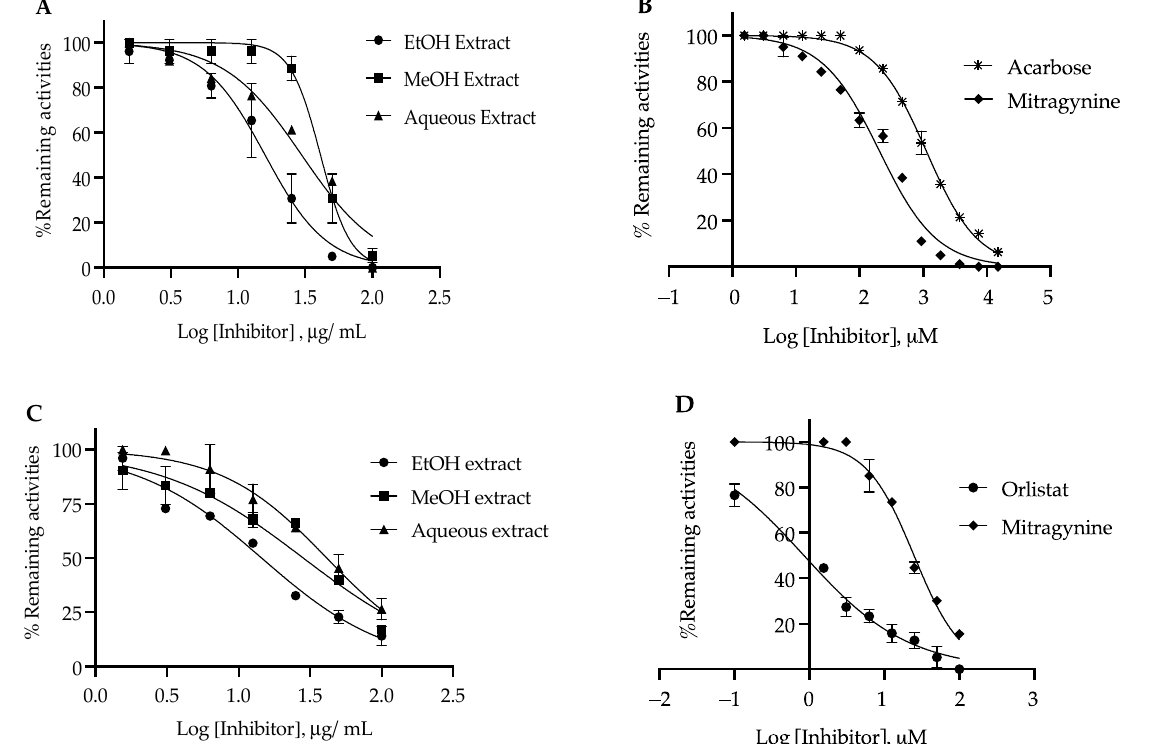
Figure 3. Inhibitory effect of the kratom extracts and mitragynine against α -glucosidase ( A , B ) and pancreatic lipase ( C , D ). Inhibition curves of acarbose ( B ) and orlistat ( D ) were used as positive controls. The inhibition kinetics of acarbose and kratom extracts against α -glucosidase were analyzed using the Lineweaver–Burk plots of the inverted values of velocity (1/V) versus the inverted values of substrate concentration (1/[S]), which are presented in Figure 4A–D. The drug acarbose showed the intersection of the lines on the ordinate, indicative of mixed- type inhibition. The results showed that k m 0.3 mM and V max (28 µ mol/min/mg) were consistent with a previous report [39]. The K i of each mode was evaluated (Figure 4A,B). The intersection on the abscissa yielded a K i value of acarbose (0.28 mM), indicating mixed- type inhibition. Mitragynine was present at concentrations of 100, 200, and 300 µ M with a K i value of 0.10 mM (Figure 4C,D). These results suggest that mitragynine is a noncompetitive inhibitor of this enzyme (Table